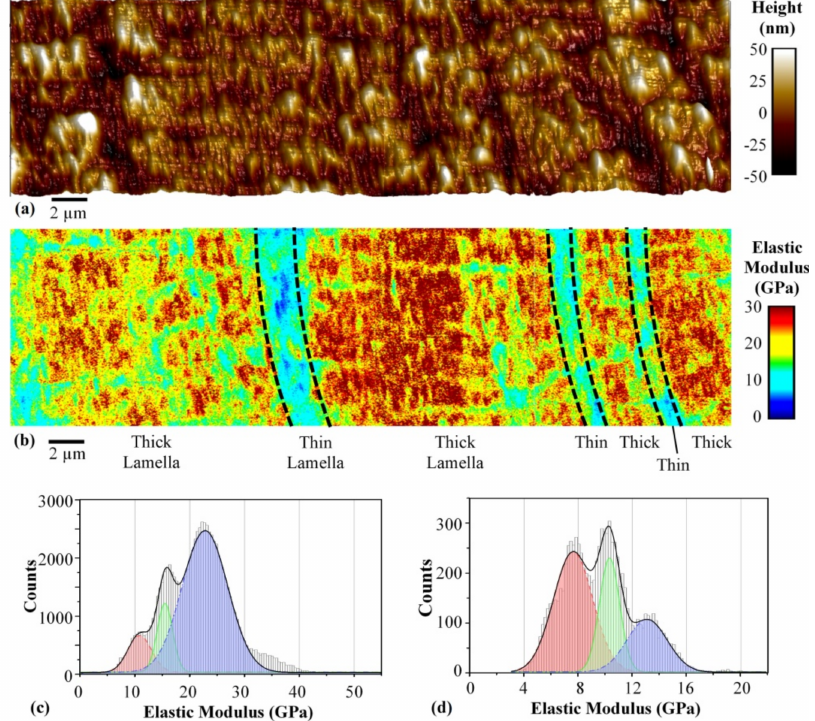
Figure 7. AFM measurement of a bovine cortical bone: ( a ) topography, ( b ) elastic modulus map, with stitched scans showing thick and thin sub-lamellae in an osteon; and measured and modeled histograms of elastic moduli for ( c ) thick sub-lamellae and ( d ) thin sub-lamellae. Reprinted from [37]. Copyright (2020), with permission from